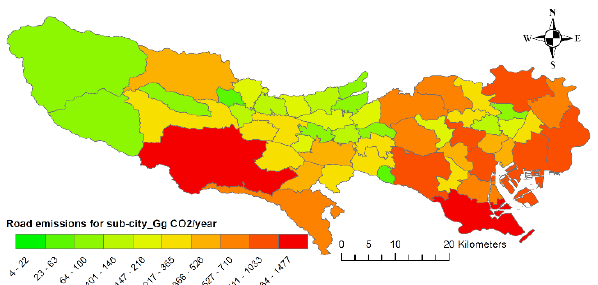
Figure 5. CO 2 emissions map on road traffic of Tokyo from EAGrid-Japan 2010, unit: Gg CO 2 yr